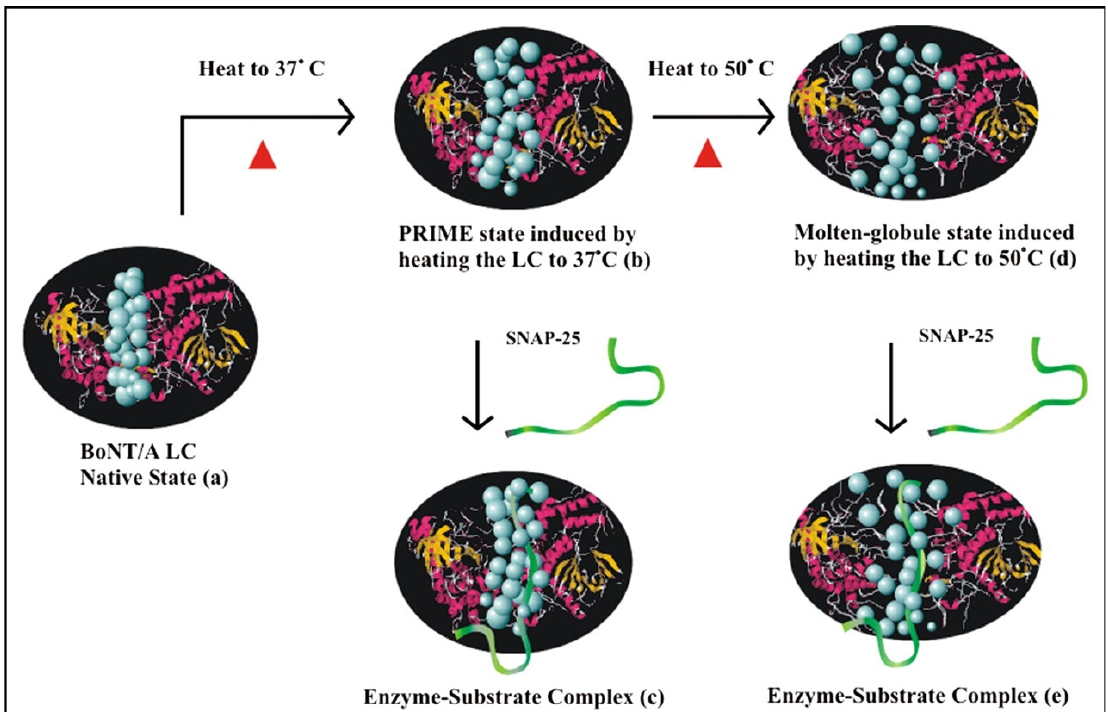
Figure 8. Schematic model representing the PRIME state and the molten globule state in BoNT/A LC facilitating the binding of substrate SNAP ‐ 25. The blue balls represent the nonpolar side chains, which are tightly packed in the native conformation. ( a ) Heating to 37 °C significantly alters the polypeptide folding, and the protein core becomes slightly loosened compared to the native state ( b ) and facilitates the binding of SNAP ‐ 25 to form the enzyme–substrate complex ( c ). BoNT/A LC exhibits the optimum activity in this PRIME state. The further heating of the BoNT/A LC leads to the formation of a molten globule intermediate, which is represented by a loose packing of the side chains in the protein core and partial unfolding of loops with a slightly more expanded structure than PRIME ( d ). While less optimal, this state of the BoNT/A LC also binds to SNAP ‐ 25, forming the enzyme–substrate complex, ( e ) and displays less enzymatic activity than the optimal PRIME state [209].